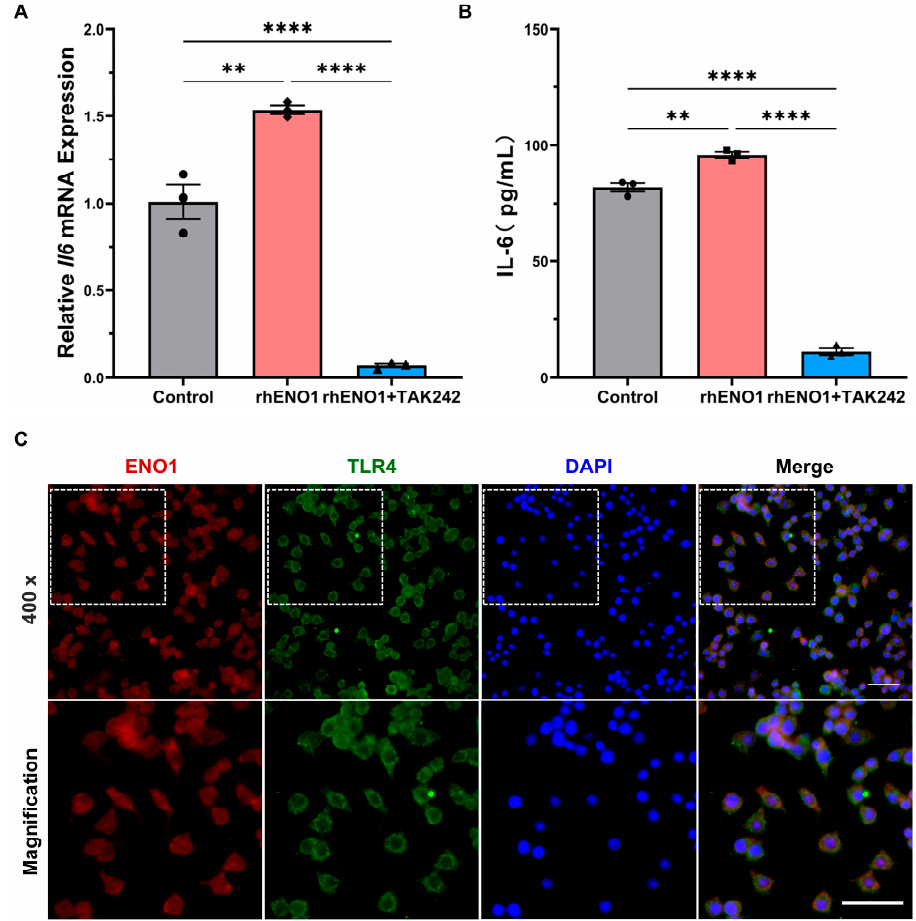
Figure 6. ENO1 orchestrates IL-6 secretion of macrophages via paracrine ENO1/TLR4 signaling pathway. ( A ) Macrophages pretreated without or with TLR4 inhibitor (TAK242, 1 µ M) supplemented in TCM were stimulated by rhENO1 for 12 h, and the mRNA levels of IL-6 in macrophages were detected by RT-qPCR analysis. ( B ) Macrophages pretreated without or with TLR4 inhibitor (TAK242, 1 µ M) were stimulated by rhENO1 for 24 h, then IL-6 protein levels in CM were assayed by ELISA. ( C ) Immunofluorescence for colocalization of ENO1 and TLR4 on macrophages. Magnification 400 × . Scale bar: 50 µ m. The area indicated on the upper left image was shown in a magnified image on the lower panel. Different symbols (circle/square/triangle) were used to represent the data points of independent biological repeated experiments. All data are displayed as mean ± SEM; n = 3; ** p < 0.01 and **** p < 0.0001.